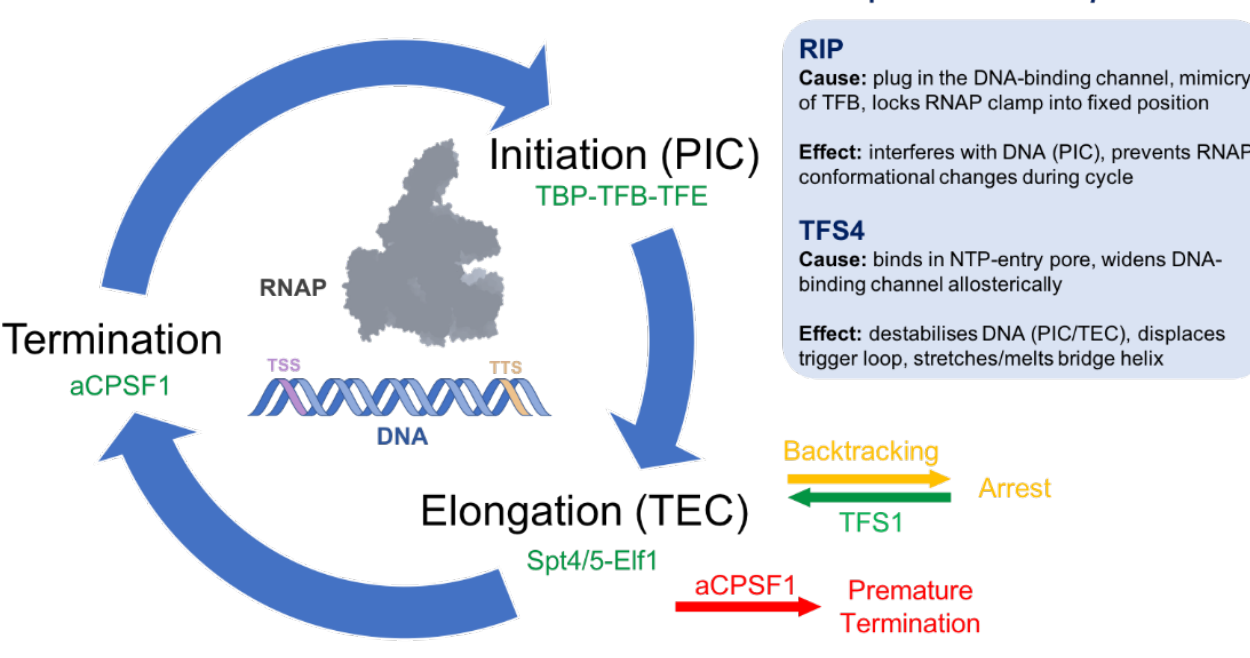
Figure 1. The archaeal transcription cycle. TBP, TFB and TFE form together with RNAP, the PIC on the archaeal promoter, to initiate transcription on the transcription start site (TSS). Following pro- moter escape, the elongation factors Spt4/5 and Elf1 associate with the RNAP forming the TEC. When encountering roadblocks, the TEC pauses, and the RNA is backtracked through the NTP- entry pore. TFS1 promotes the cleavage of the ‘excess’ of RNA in the pore, creates a new RNA 3′ - end, which reactivates the TEC. Transcription termination can occur through a factor-independent or -dependent mechanisms at the transcription termination site (TTS) and utilises aCPSF1. aCPSF1 is also recruited proximal to the promoter where it can lead to premature termination. The inhibitory regulators RIP and TFS4 interfere with RNAP as it progresses through the transcription cycle as listed in the light blue